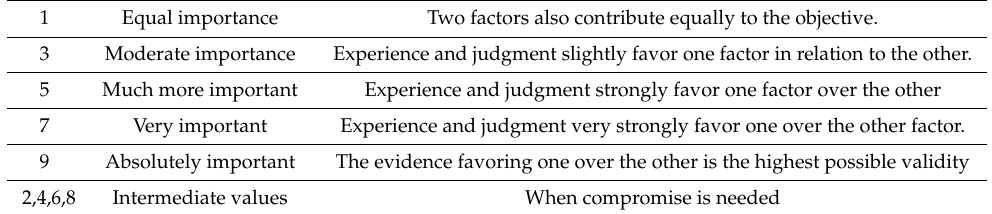
Table 2. Scale to develop the pairwise comparison